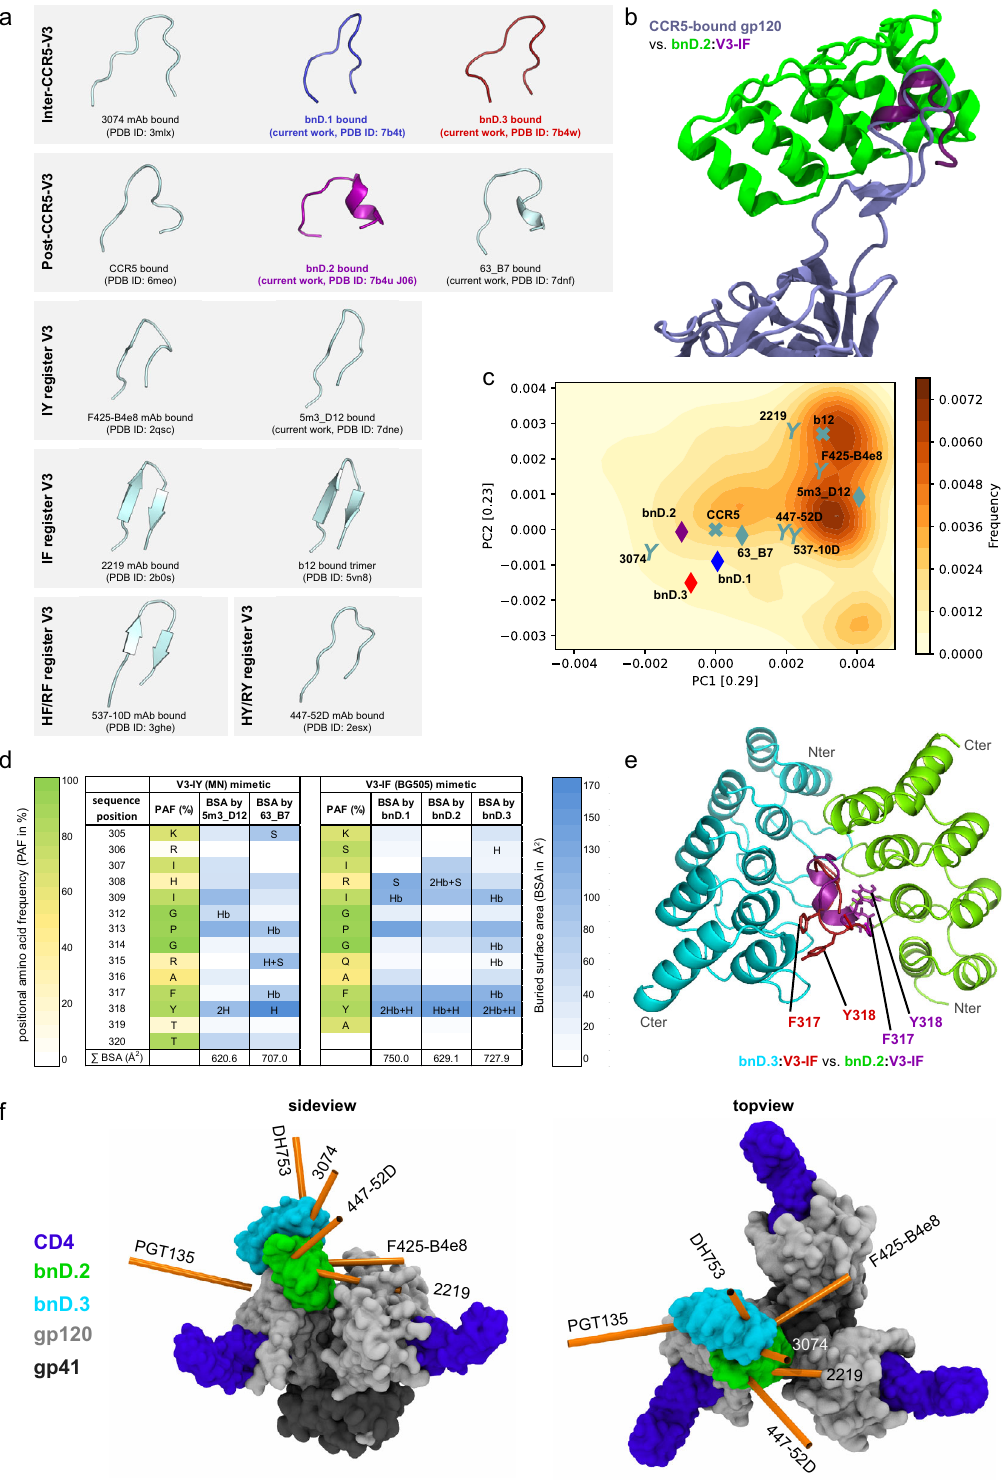
strongest competition was observed for mimetic V3-IF, and bnD.3 favored V3-RY, V3-IY, and V3-IF. Crystal structures of the V3-crown DARPin: epitope complexes reveal two distinct V3 conformations linked to broad neu- tralization . In order to de fi ne V3-crown epitopes that lead to broad neutralization, we co-crystallized bnDs with V3-IF (BG505), i.e., the